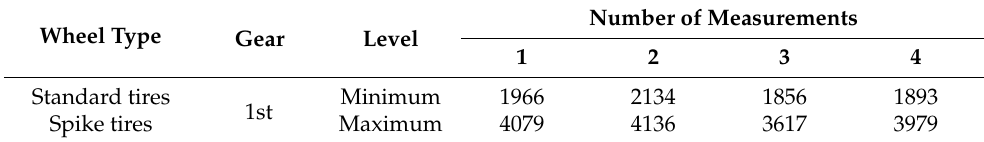
Table 4. Drawbar pulls of four measurements